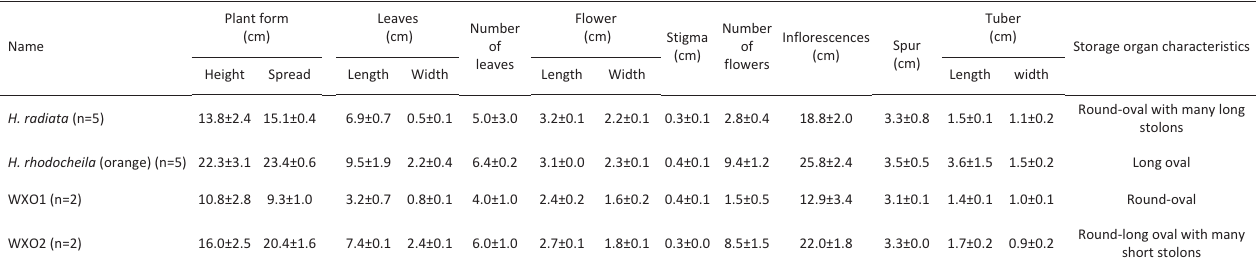
Table 2 ­ Morphology characteristics of two Habenaria species and interspecific